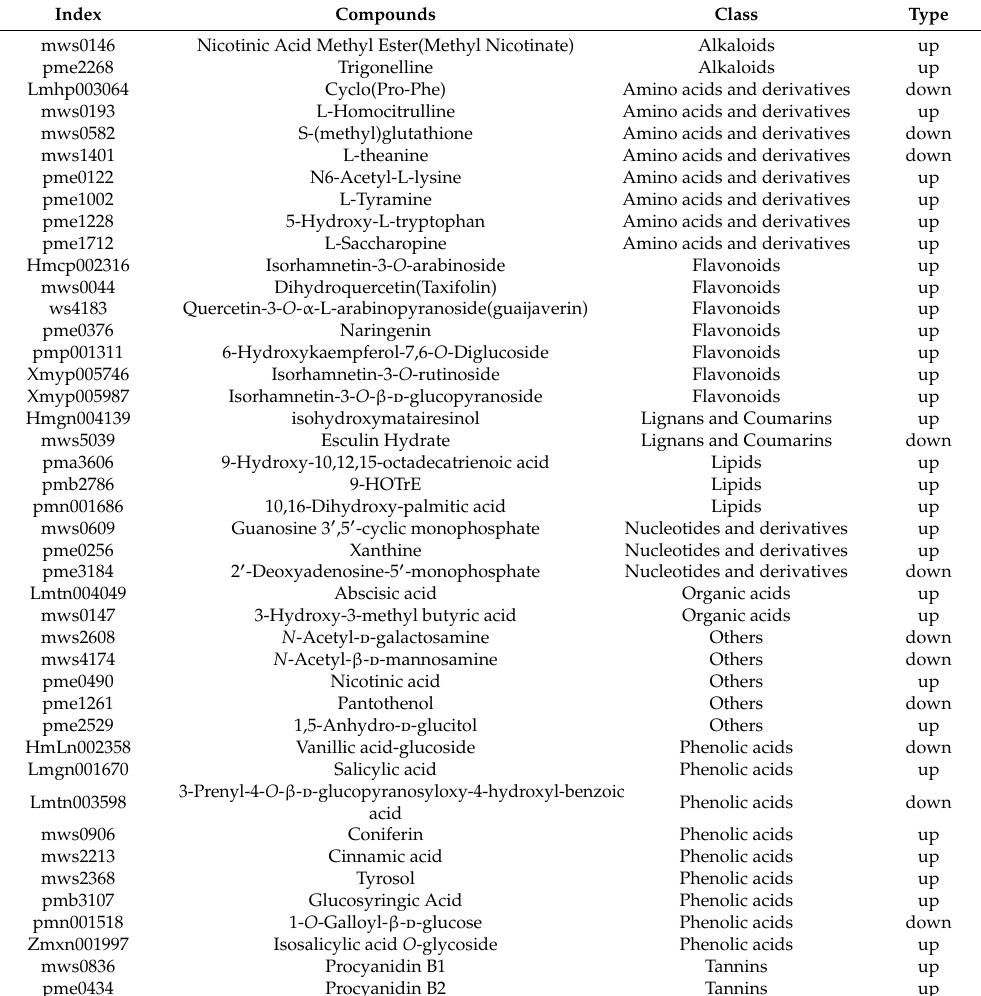
Figure 4. Di ff erential metabolites commonly and specifically accumulated in WT vs. a-3, WT vs. a-4, and WT vs. a-5. Venn diagrams show the distribution of DAMs in WT vs. a-3, WT vs. a-4, and WT vs. a-5. Table 4. Common di ff erentially accumulated metabolites in WT vs. a-3, WT vs. a-4, and WT vs.